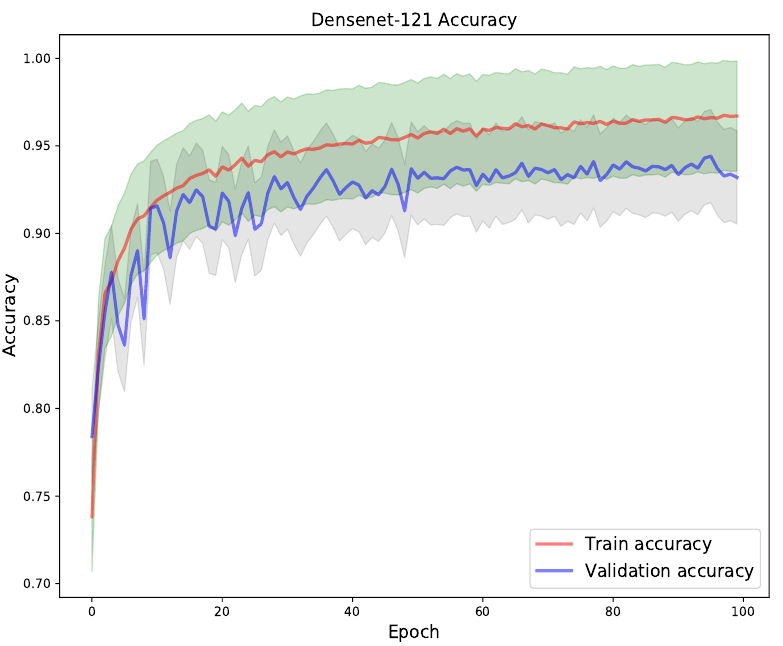
Figure 14. Train vs validation accuracy. The model showed unstable convergence behaviour in the first 45 epochs as the graphs show off-shooting effects in both train and loss metrics.